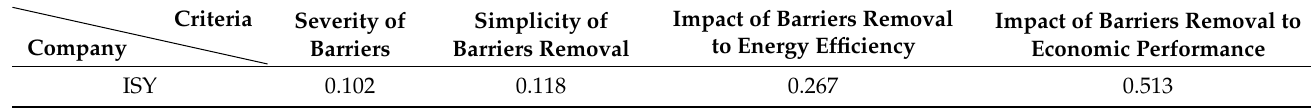
Table 2. Ranking of criteria.